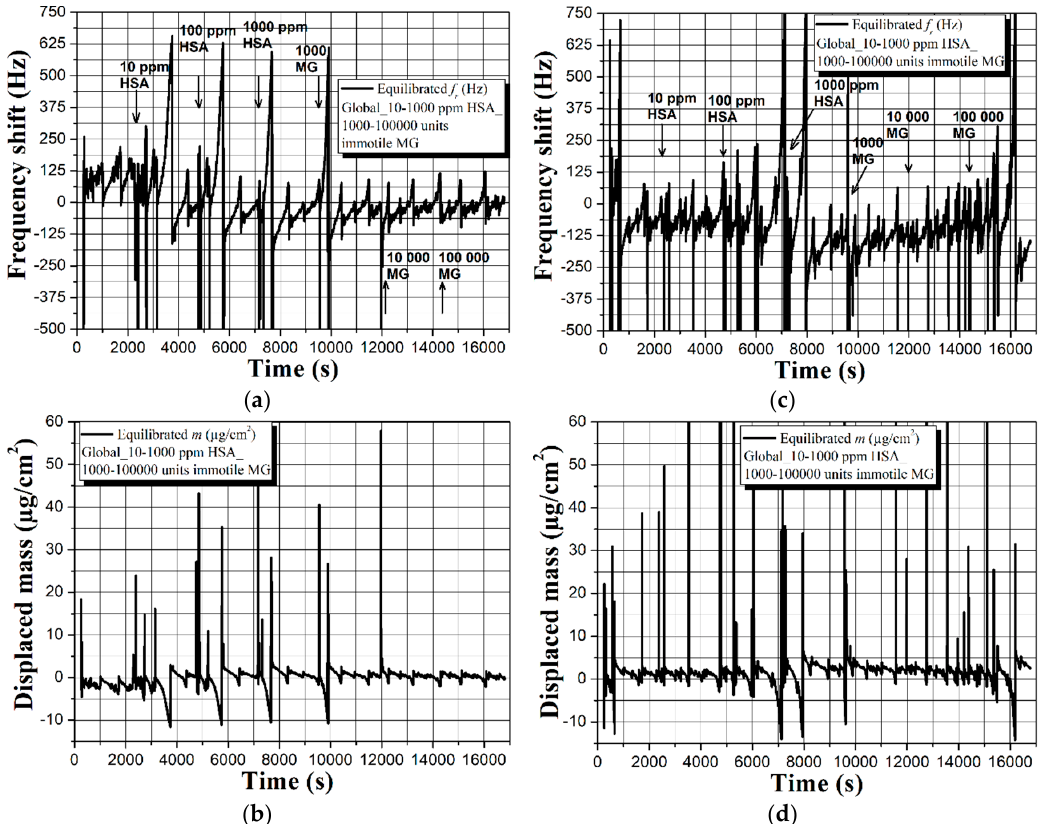
Figure 2. Real-time sensor response of an uncoated 5 MHz quartz crystal microbalance (QCM) to human serum albumin (HSA) and immotile human spermatozoa with gradually increasing concentration and its repeatability in two independent measurement cycles ( a – d ). All graphs reflect actual biomass effects and/or possible viscosity-density changes after equilibration of the baselines in Global